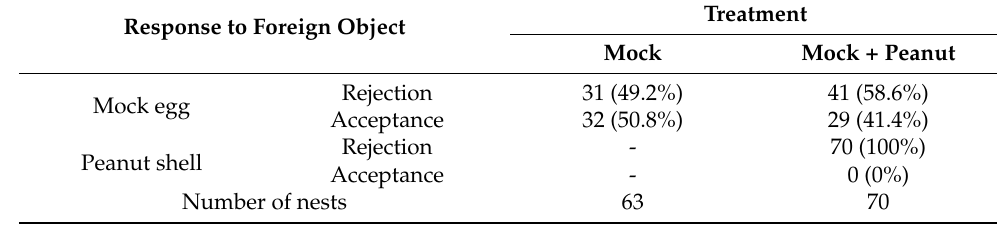
mock egg plus peanut shell trial (mock + peanut).